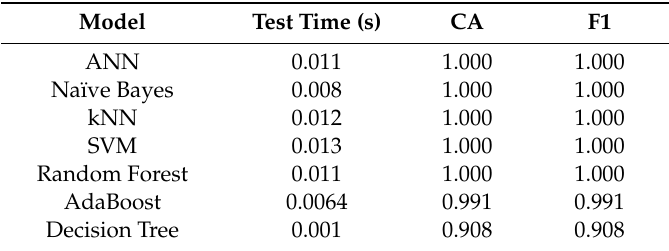
Table 4. Classifiers performance, in the test dataset, using all the 17 input features. Model